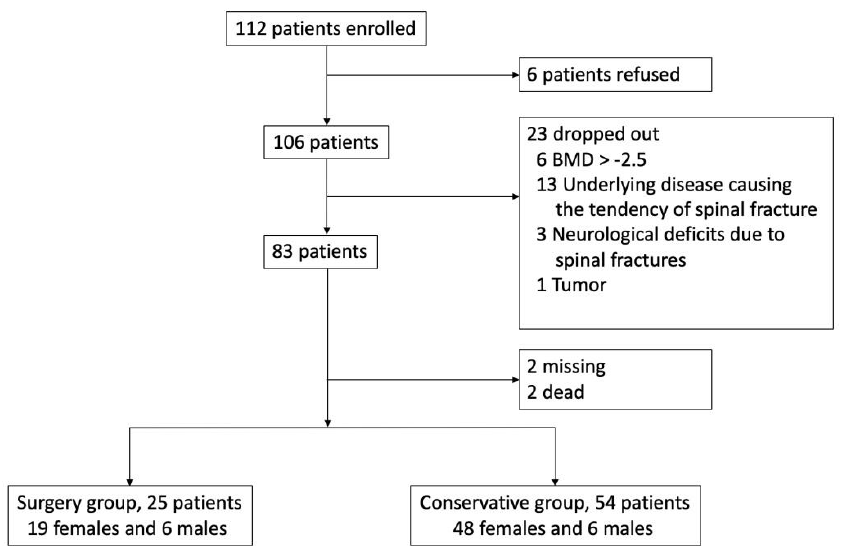
Figure 2. During the study period, 112 patients were seen at our hospital due to compression fractures. Six patients declined to participate in the study, and 106 of the 112 patients were enrolled in this prospective cross-section cohort study. Twenty-three patients were excluded; 6 patients had a T-score > −2.5, 13 had an underlying disease that increased the risk of a spinal fracture, 3 had neurological deficits after fractures, and one was found to have spinal metastasis. An additional 4 patients were also excluded; 2 were lost to follow-up and 2 died during the follow-up period. Table 1. Patient characteristics.